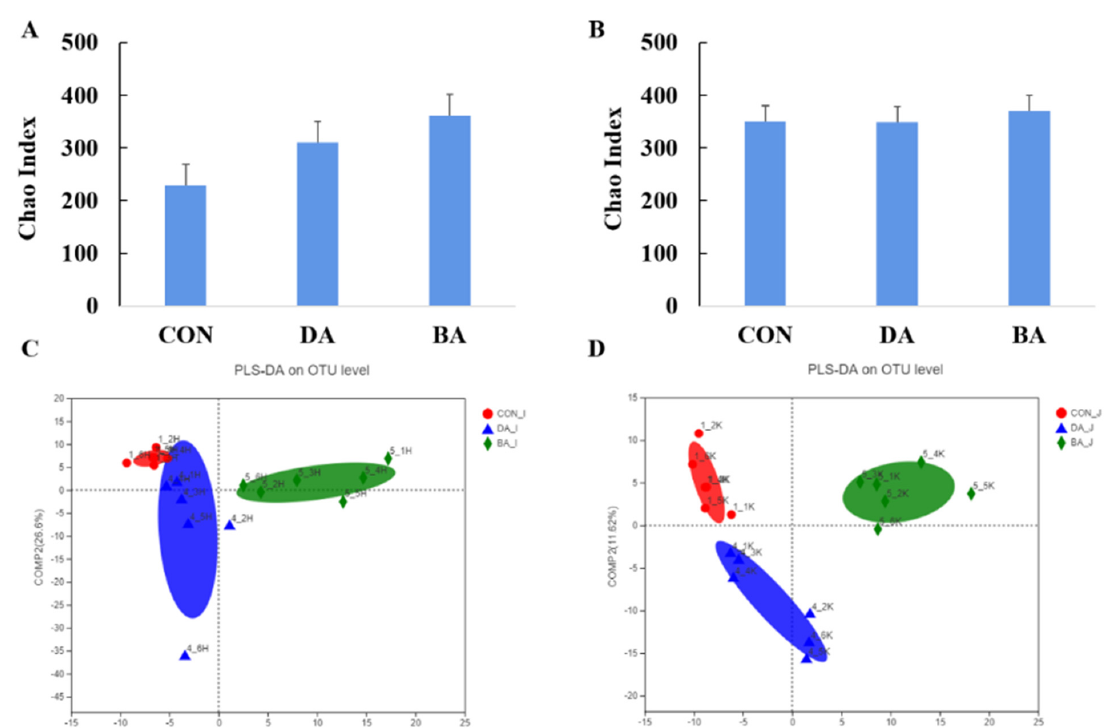
Figure 5. Effects of sodium decanoate and sodium butyrate on α and β diversity of intestinal flora of C57BL/6 mice (Exp. 2). ( A ) Chao index of microbiota in the ileum. ( B ) Chao index of microbiota in the colon. ( C ) PLS-DA analysis to β diversity in the ileum at the OTU level. ( D ) PLS-DA analysis to β diversity in the colon at the OTU level. A total of 36 mice with weaning age of 28 d were allocated into three dietary treatments randomly, which are control (CON), 5 g/kg sodium decanoate (DA), and 5 g/kg sodium butyrate (BA) diets. At the end, the intestinal digesta sample from each mouse was collected from the approximately middle positions in the ileum and colon to evaluate microbial community composition using high-throughput sequencing.